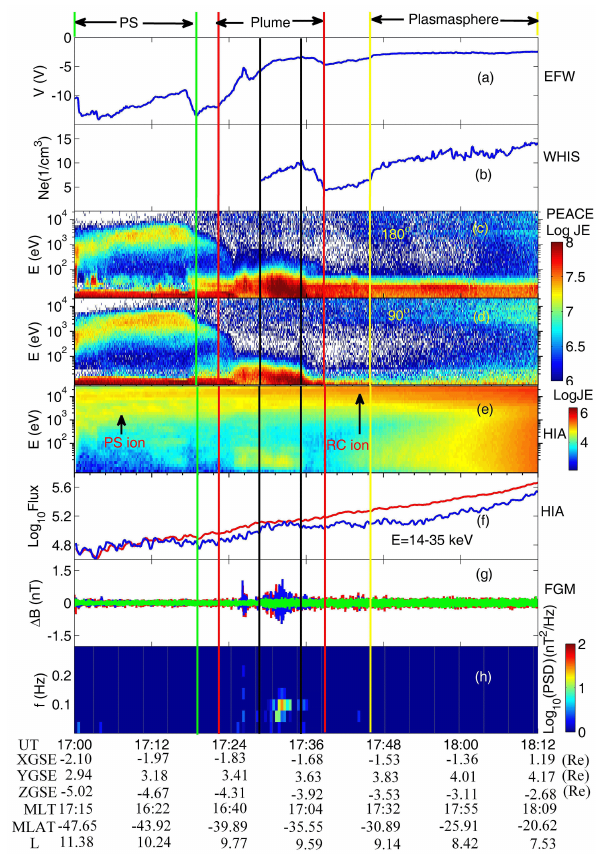
Figure 4. Overview of data from Cluster 3 between 17:00 and 18:12UT on 3 June 2004. Panel (a) : negative of the space- craft potential measured by the EFW experiment. Panel (b) : elec- tron density derived from the electron plasma frequency de- tected by the WHISPER instrument. Panels (c–d) : PEACE elec- tron energy–time spectrogram in particle energy flux units (keV cm − 2 s − 1 sr − 1 keV − 1 ) at pitch angles of 180 and 90 ◦ , respectively. Panel (e) : HIA omnidirectional energy–time spectrogram in energy particle flux units (keVcm − 2 s − 1 sr − 1 keV − 1 ) . Panel (f) : ion flux with energies of 14keV–35keV measured by HIA. Ion fluxes with local pitch angles of 80–90 and 170–180 ◦ are denoted by red and blue lines, respectively. Panel (g) : disturbed magnetic field in the field-aligned coordinate system. The two perpendicular components ( (cid:49)B t1 and (cid:49)B t2 ) and the field-aligned component ( (cid:49)B FA ) of the perturbed magnetic field in the field-aligned coordinate system are denoted by red, blue, and green solid lines, respectively. Panel (h) : power spectral density (PSD) of the (cid:49)B t2 component of the dis- turbed magnetic field. Black vertical solid lines denote the time in- terval of enhanced PSD for Pc2